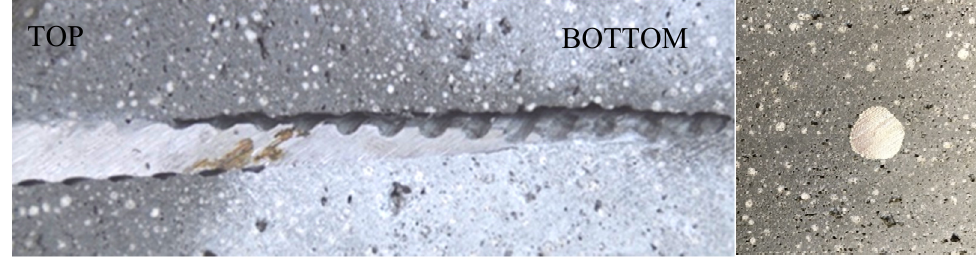
Figure 15. Void formation around the vertically inserted rebar ( left ). Bond between horizontally deposited rebar and mortar ( right ).